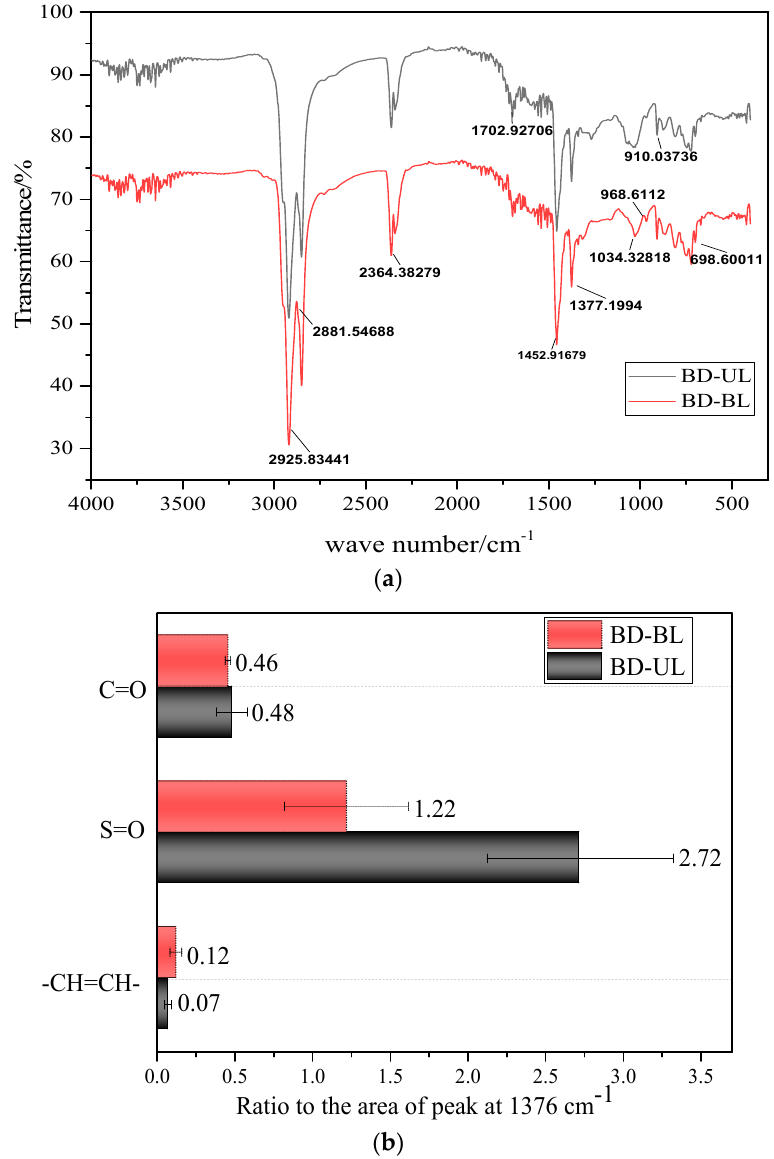
Figure 6. Composition changes of bitumen from BD-UL and BD-BL. ( a ) Infrared spectra; ( b ) quantitative analysis diagram.